Question: Summarize what this figure shows in one sentence.
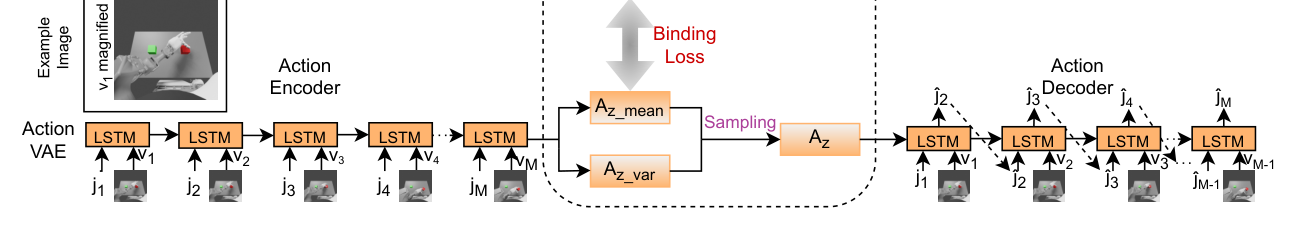
Answer: The architecture of the proposed PVAE and PVAE-BERT models: the language VAE (blue rectangles) processes descriptions, whilst the action VAE (orange rectangles) processes joint angles and images at each time step. The input to the language VAE is the given description x, whereas the action VAE takes as input joint angle values j and visual features v. The two VAEs are implicitly bound via a binding loss in the latent representation space. The image from which the v1 is extracted is magnified for visualisation purposes. <BOS> and <EOS> stand for beginning of sentence and end of sentence tags, respectively. The two models differ only by the language encoder employed: the PVAE uses LSTM, whereas PVAE-BERT uses a pretrained BERT model.